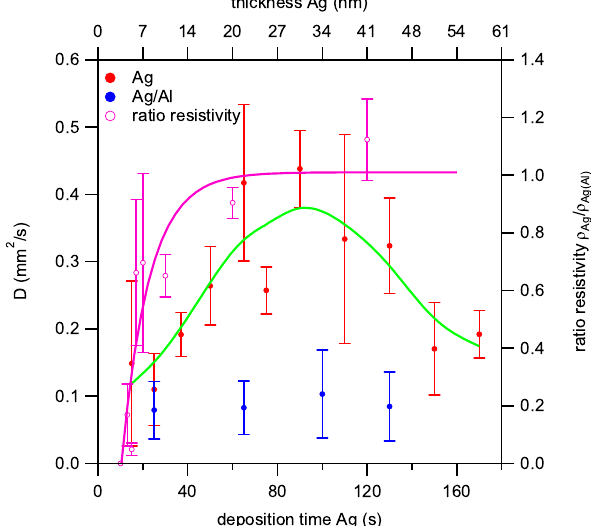
Figure 3. Influence of the film thickness/deposition time on the diffusivity for silver thin films deposited on glass without seed layer (red) and with an Al seed layer (blue). The green line is a smoothed spline through the data points related to the growth rate of the corrosion spot. The ratio of the resistivity, as measured ex situ using a Van der Pauw set-up, between film deposited with and without seed layer is shown on the right hand axis (purple points and line (only to guide the